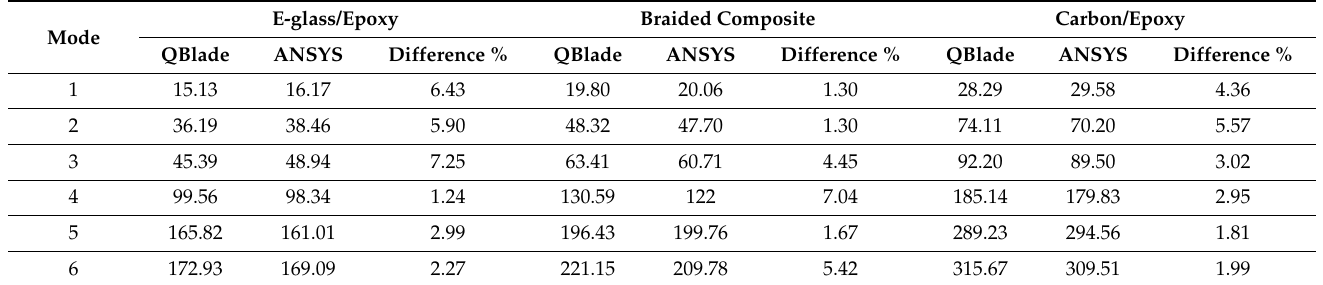
Table 7. The comparison of Frequencies using different